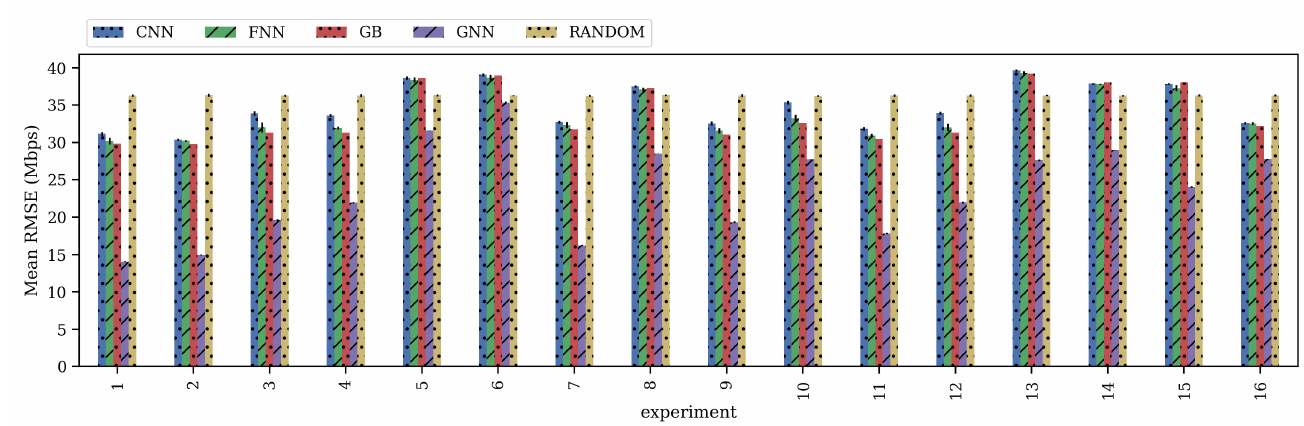
Figure 8. Mean and standard deviation of the obtained RMSE by all models on the test data